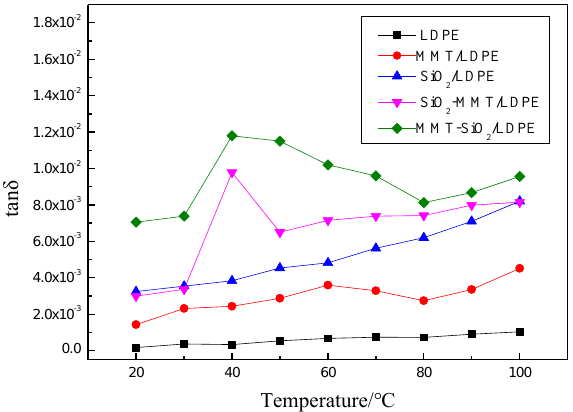
Figure 8. Curves of tanδ with respect to T.